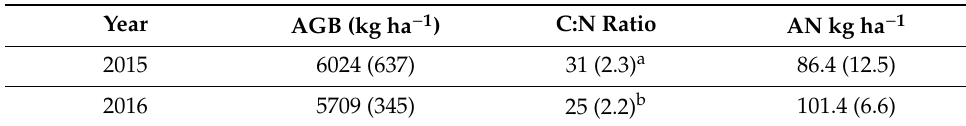
Table A1. Above ground biomass (AGB), carbon to nitrogen (C:N) ratio, and additional nitrogen (AN) means and associated standard errors (n = 4) of the grassland set-aside in the 2015 and 2016 growing seasons.